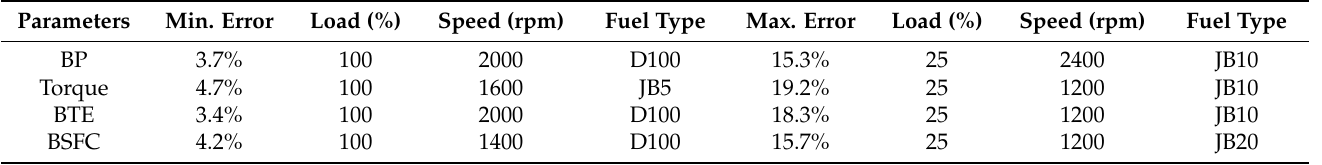
Table 6. Comparison of simulation and experimental